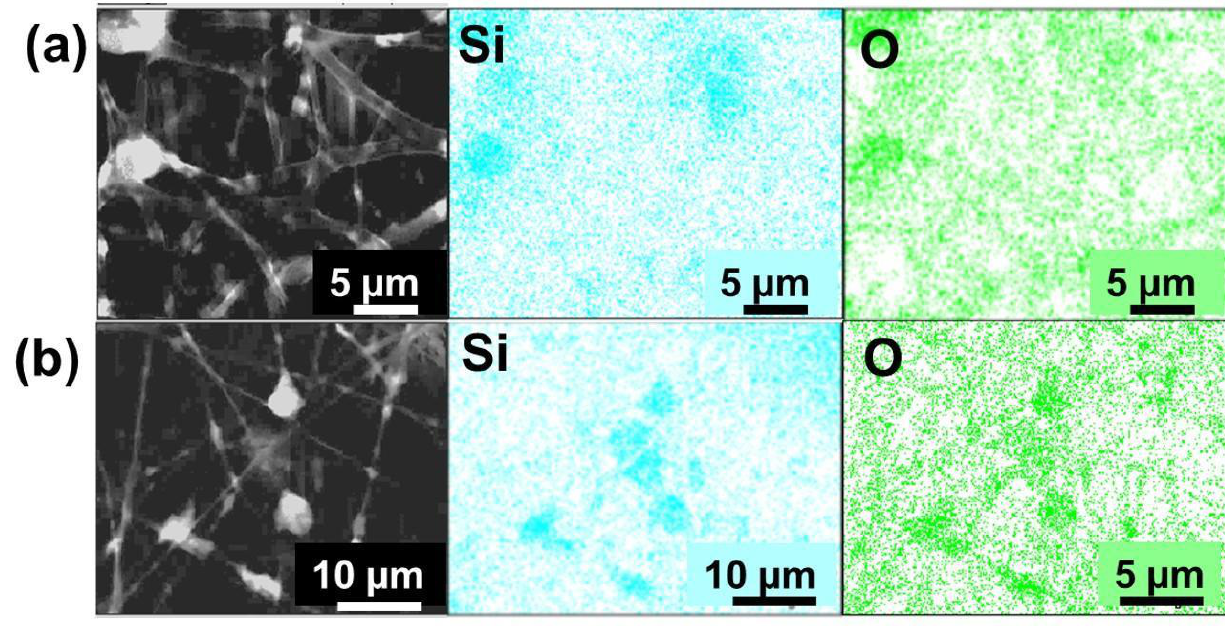
Figure 8. SEM-EDX images of PLA:SiO 2 membranes: ( a ) SGSil and ( b ) RHSil.